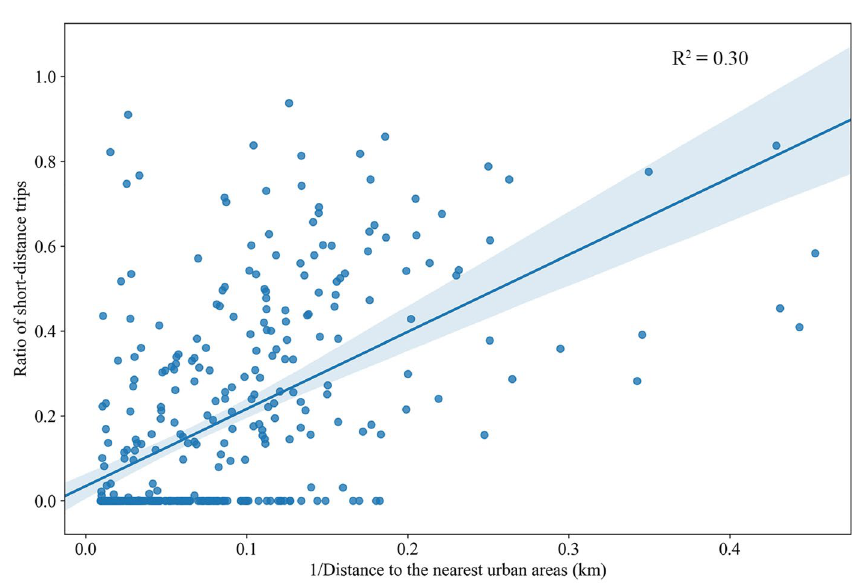
Figure 2. Scatter plot with the ratio of short-distance trips as a function of the inverse of the distance to the nearest urban